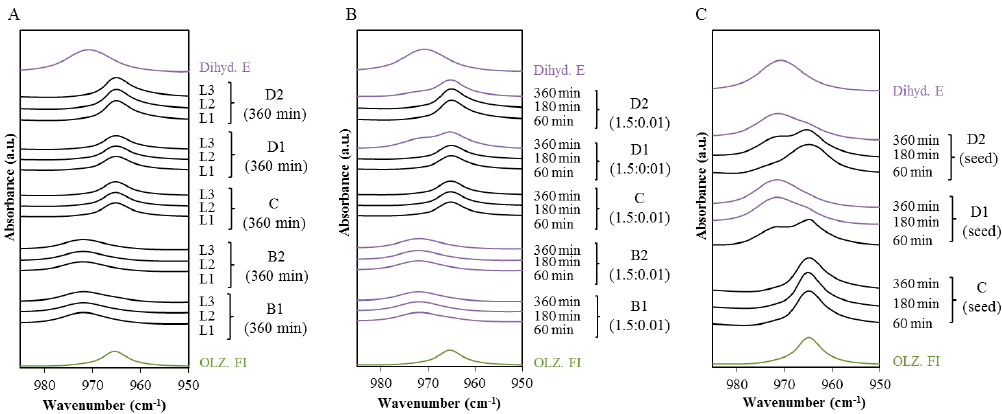
Figure 4. Spectra (FTIR) in the region (990–950 cm − 1 ) for the different OLZ:polymer formulations (B1, B2, C, D1, and D2). ( A ) Formulations were wet massed with 3 levels of water L1 (50 g), L2 (75 g), L3 (100 g). The spectra were collected after 360 min mass preparation; ( B ) The polymer content had a two order of magnitude reduction (1.50 OLZ:0.01 Polymer); ( C ) Wet masses C, D1 and D2 with seeds (5%). The spectra were collected at 60, 180 and 360 min after the wet mass preparation.